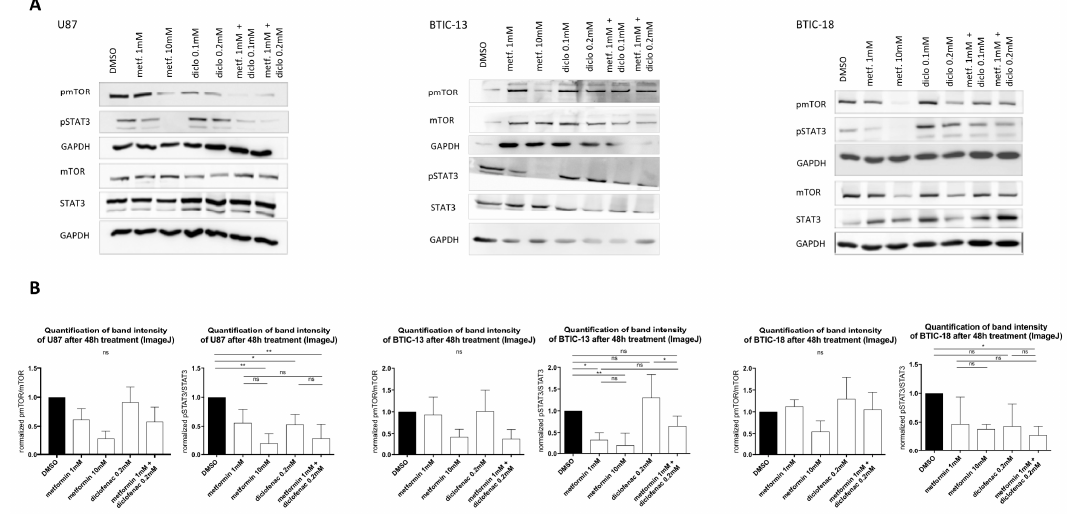
Figure 4. ( A ) Protein levels of the (phosphorylated) mammalian target of rapamycin (p)mTOR, (phosphorylated) signal transducer and activator of transcription 3 (p)STAT3 and GAPDH